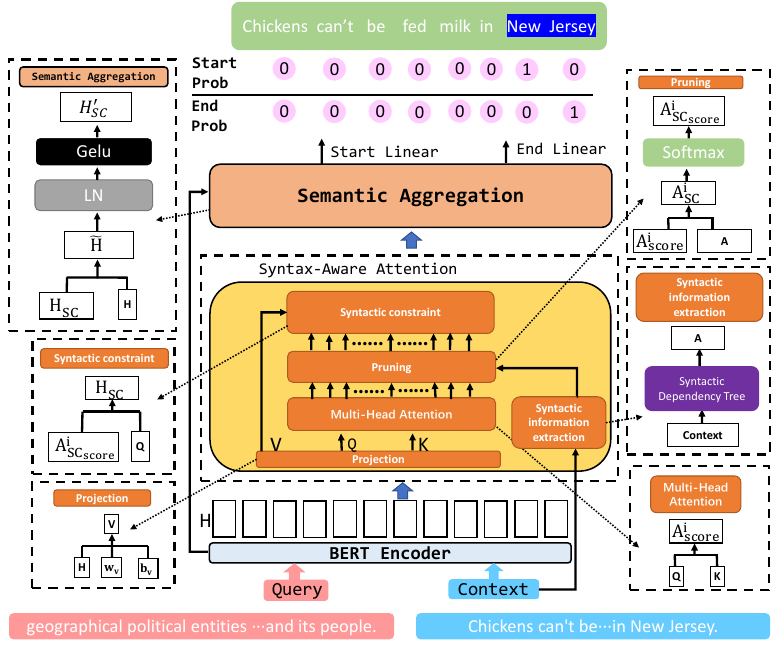
Figure 3. Illustration of the SCAN-Net